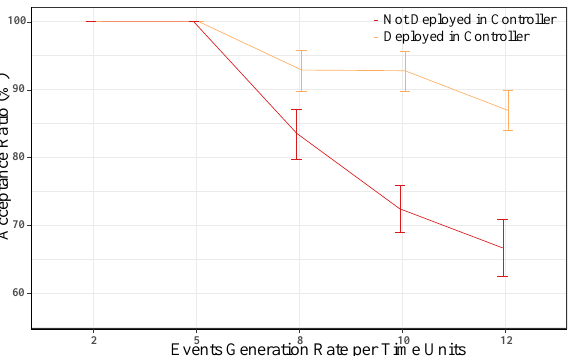
Figure 6. Average event acceptance ratio with and without deploying events in the controller node.